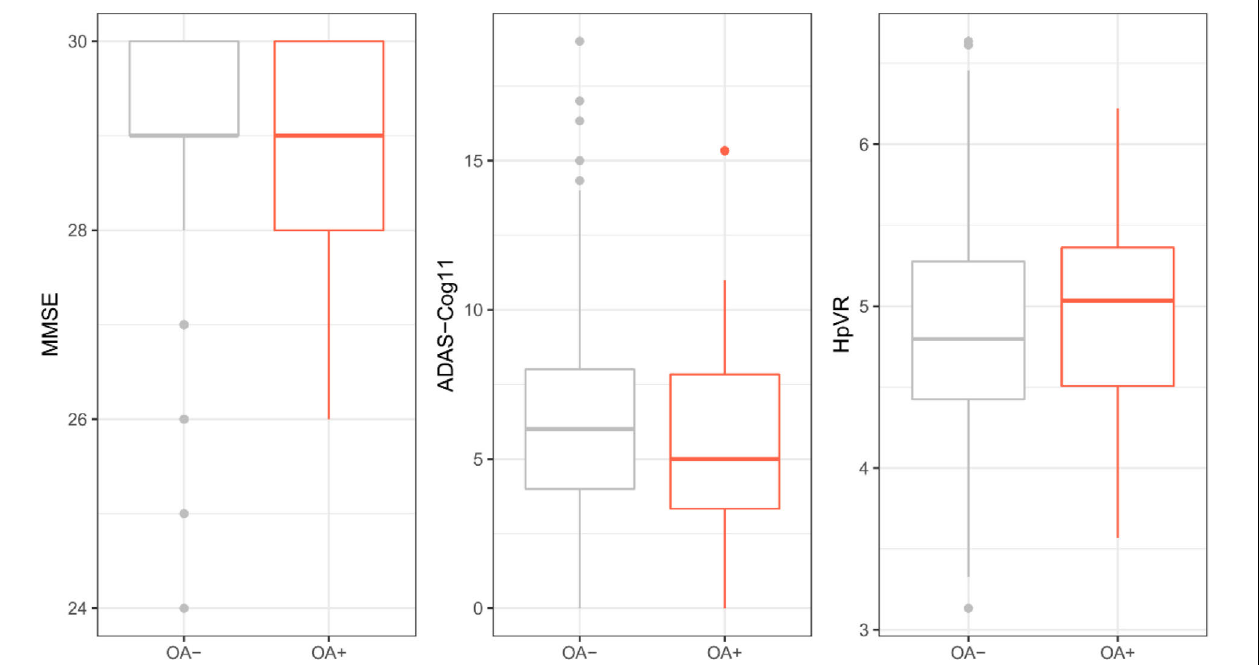
FIGURE 2 | Cross-sectional association of OA with MMSE, ADAS-Cog11, and HpVR among individuals with NC. There was no significant difference in MMSE, ADAS-Cog11, or HpVR between the two groups (all p > 0.05). OA: osteoarthritis; MMSE: mini-mental state examination; ADAS-Cog 11: Alzheimer’s disease assessment scale-cognitive 11-item. HpVR: hippocampal volume ratio (HpVR, hippocampal/intracranial volume × 10 3 ).